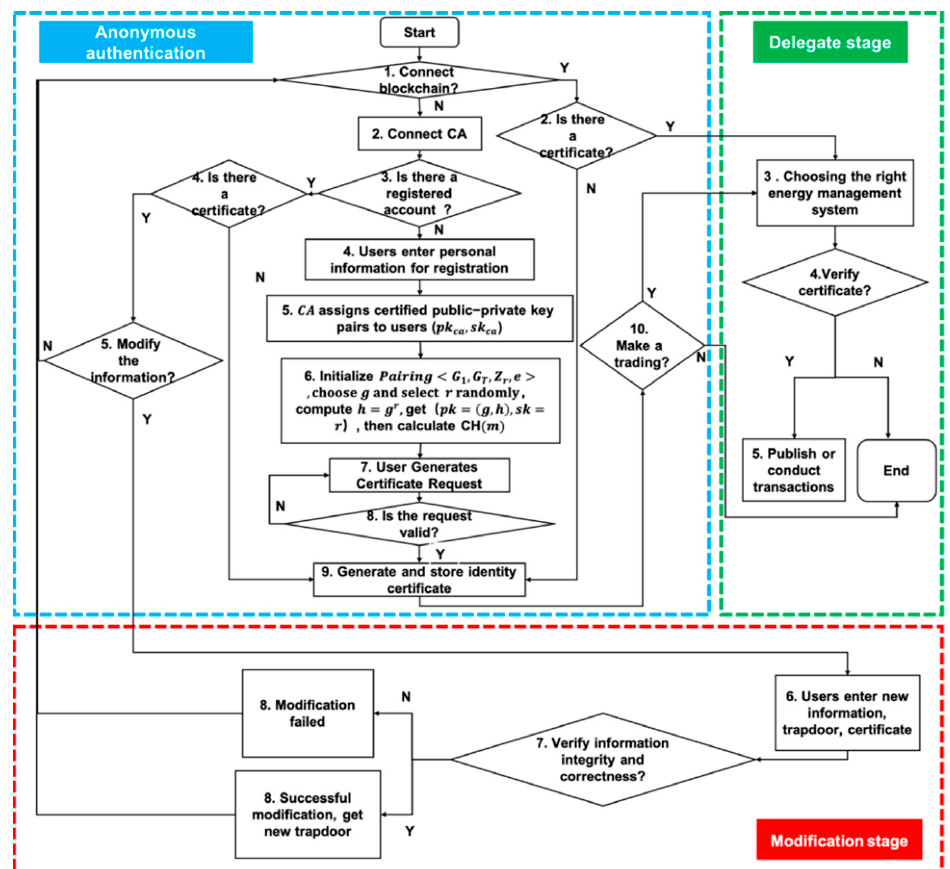
Figure 2. Overall flow chart.